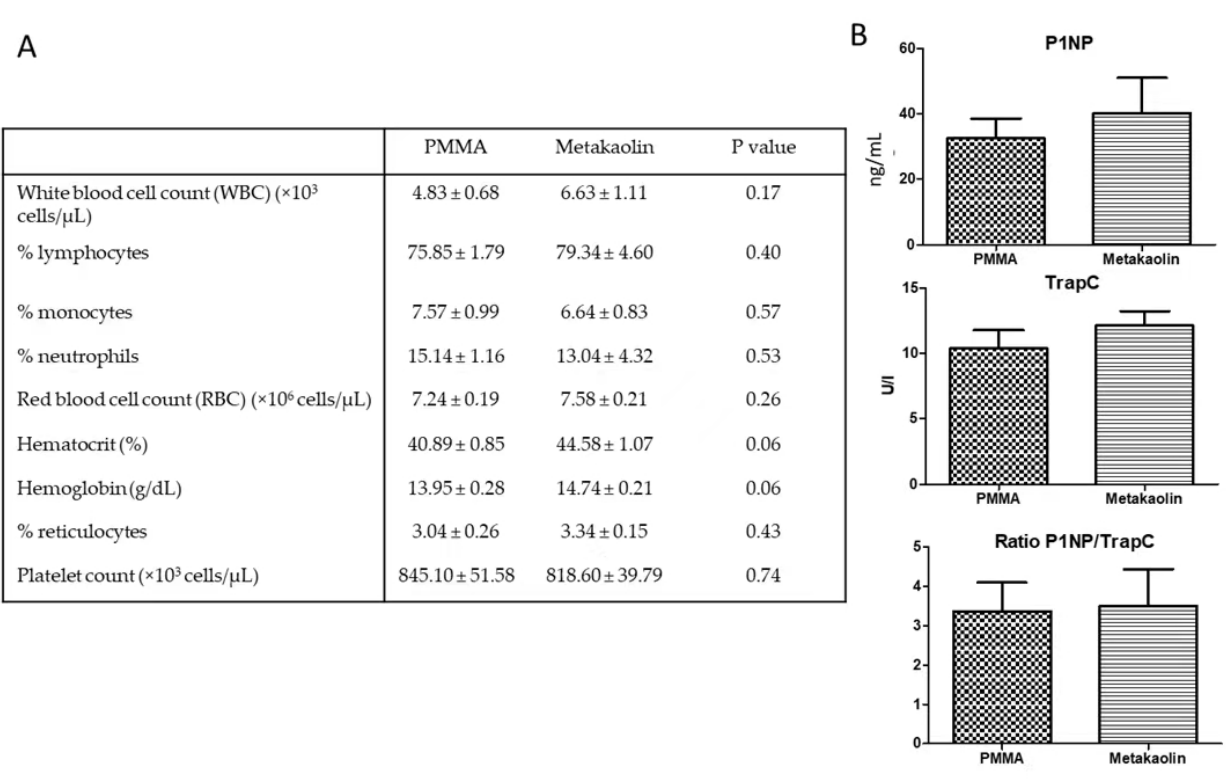
Figure 1. Panel ( A ) shows the hematological parameters of animals four weeks after spacer im- plantation. Blood was collected into EDTA-containing tubes when the animals were killed, and blood parameters were determined with an optical hematology analyzer (MS-9, Melet Schloesing) with rat-specific analysis software. Panel ( B ) shows the serum levels of bone turnover markers, as determined by ELISA, four weeks post-spacer implantation. Concentrations of a bone formation marker P1NP ( top ) and a bone resorption marker TRAP-C ( middle ) were determined, and turnover for bone remodeling was evaluated by calculating the P1NP/TRAP-C ratio ( bottom